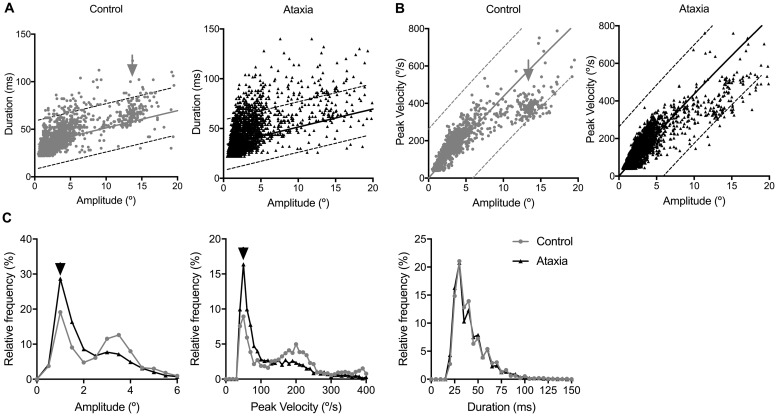
Saccades were irregular and abnormal in ataxia patients compared with controls while reading 120 regularly spaced single-digit numbers aloud.(A) Main sequence relationship scatter plots of saccade amplitude (°) vs. duration (ms) and (B) saccade amplitude (°) vs. peak velocity (°/s) for controls (grey) and ataxia patients (black). In controls, there was a clear cluster of larger amplitude line-changing saccades (black arrows) that was less prominent in ataxia patients. A linear regression model (saccade amplitude vs. duration) and one phase exponential equation (saccade amplitude vs. peak velocity) was used to fit data from saccades by controls with 5% and 95% prediction bounds dotted. (C) Relative frequency power analysis of saccade amplitude (°), peak velocity (°/s), and duration (ms) for controls and ataxia patients showed that compared with that of controls, the peak relative frequency of saccade amplitude and peak velocity was smaller and slower, respectively, in ataxia patients (black arrowheads).